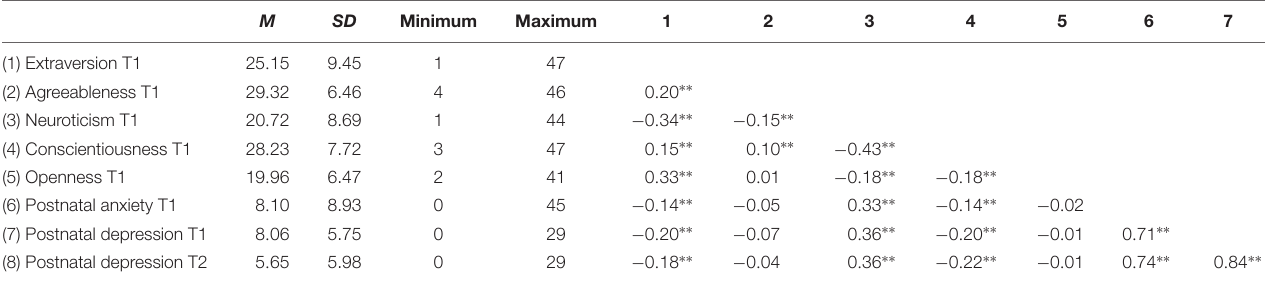
TABLE 1 | Zero-order correlations between personality traits, postnatal anxiety and postnatal depression for the entire sample. M SD Minimum